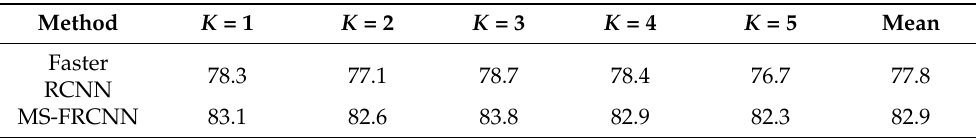
Table 2. Five-fold cross-validation of the Faster RCNN and the MS-FRCNN on the training set and the test